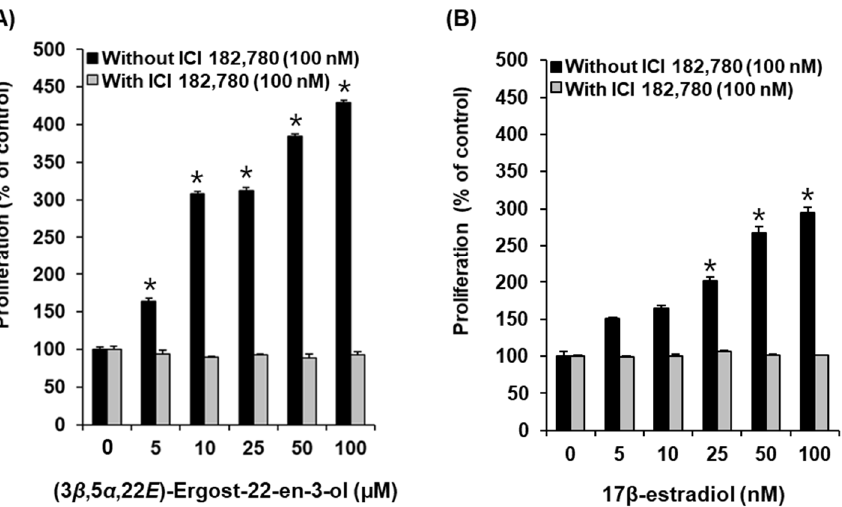
Figure 5. Comparison of estrogenic activities of ( A ) (3 β ,5 α ,22 E )-ergost-22-en-3-ol ( 4 ) and ( B ) 17 β - estradiol (E2) in the absence or presence of ICI 182,780, as determined by cell proliferation measured by E-screen assay in MCF-7 cells. * Significant difference between untreated cells and cells treated with sample in the absence of ICI 182,780 ( n = 3 independent experiments, p < 0.05, Kruskal–Wallis nonparametric test). Data are the mean ± SEM.